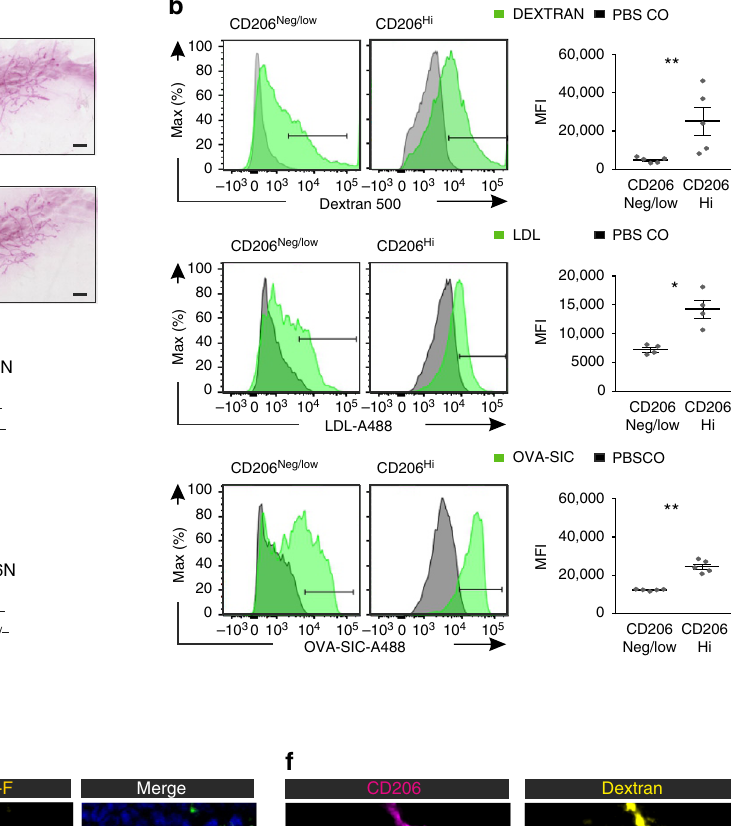
the cells were incubated for 1h with DNA intercalation solution (1:1000 Cell ID Intercalator-103Rh in MaxPar ® Fix and Perm Buffer; cat. 201067; Fluidigm) at room temperature, fi xed with 4% paraformaldehyde solution (PFA; Santa Cruz Biotechnology; cat. sc-281692) overnight and then pelleted. The cells were resus- pended to MaxPar Water (cat. 201069; Fluidigm) immediately prior to data acquisition with a CyTOF mass cytometer (Helios, Fluidigm). Bead normalized mass cytometry data were gated for live (Cisplatin − ) singlets ( 191 Ir + ), and applied the t-SNE algorithm to analyze and visualize the multidimensional data in two-dimensions (viSNE,Cytobank, https://www. cytobank.org). A proportional event sampling using 18,000 – 25,000 events per sample in CD45 analysis, and 3000 – 14,000 events in CD11b analysis, was selected.